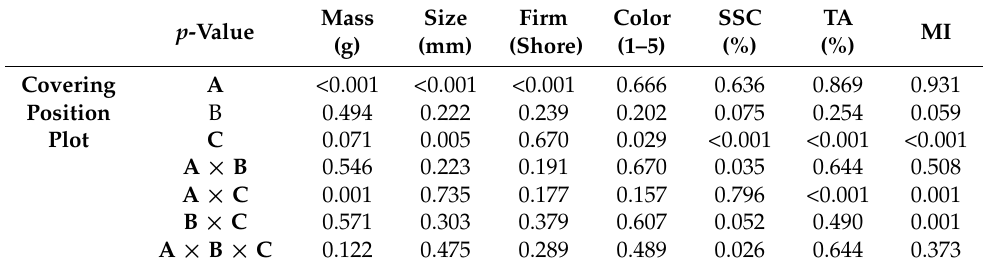
Size: diameter; Firm: fruit firmness; SSC: soluble solid content; TA: titratable acidity; MI: maturity index. Quality characteristics with p -values below 0.05 denote significant differences between treatments based on ANOVA. The